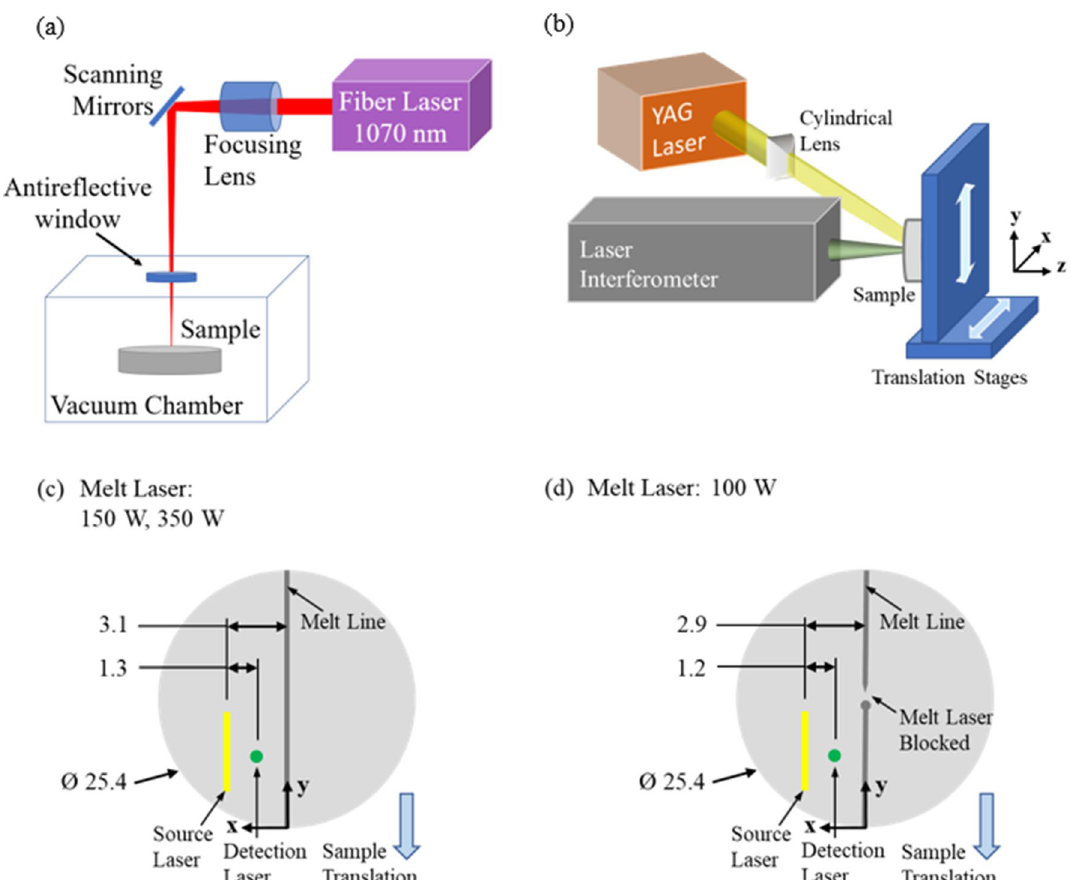
Figure 2. ( a ) Experimental setup for producing the laser melted line scans. ( b ) Experimental setup for generating and detecting surface acoustic waves. A pulsed laser is used to generate ultrasound and the displacement is measured using a photorefractive interferometer. ( c , d ) Geometry of sample(s) and location of source and detection relative to the melt line (units in mm). The melt line is scanned by translating the sample in the -y